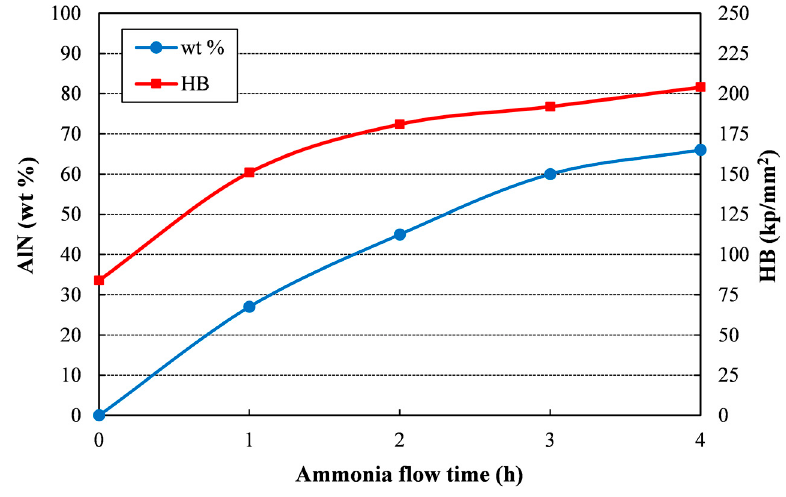
Figure 4. AlN wt % and hardness versus ammonia flow time of the different sintered compacts.